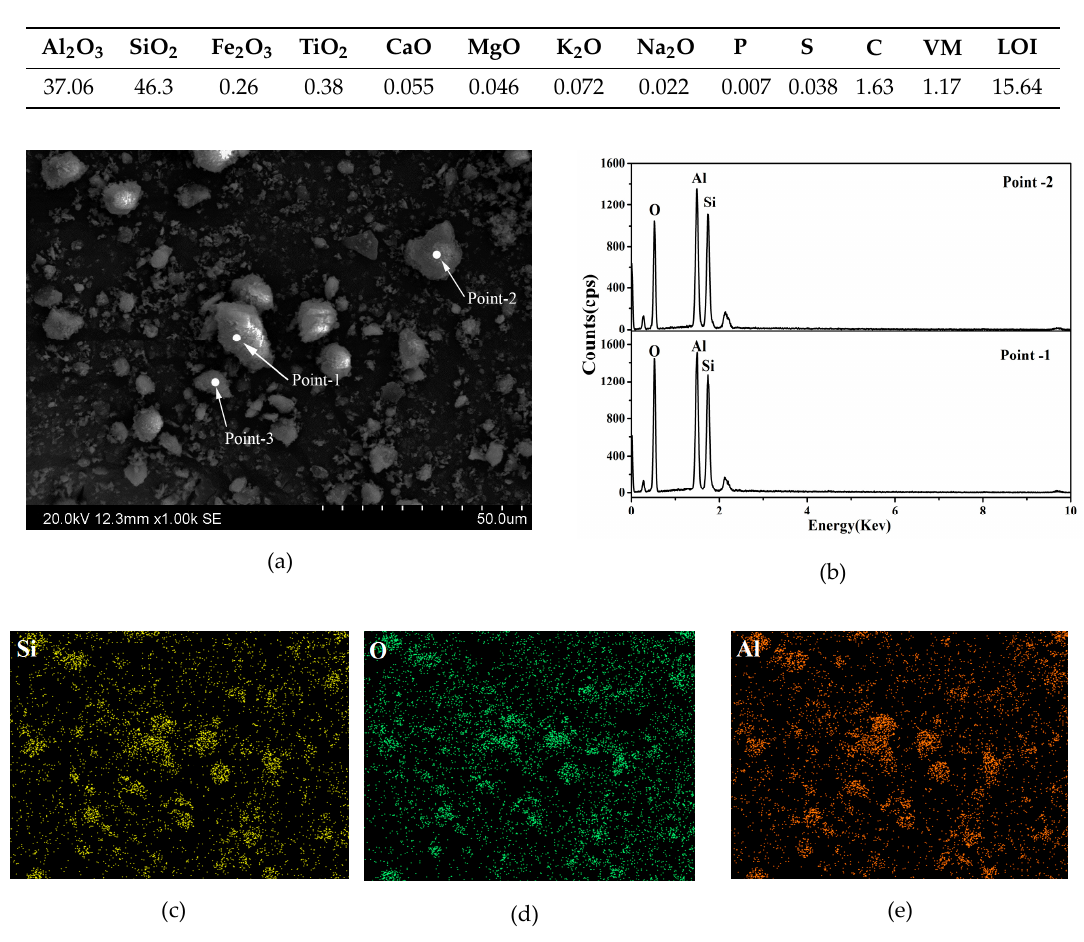
Figure 3. Scanning electron microscope (SEM) images and energy dispersive spectrometer (EDS) analysis of raw coal gangue. ( a ) SEM image; ( b ) Spot scanning; ( c ) Surface scanning of Si element; ( d ) Surface scanning of O element; ( e ) Surface scanning of Al element.